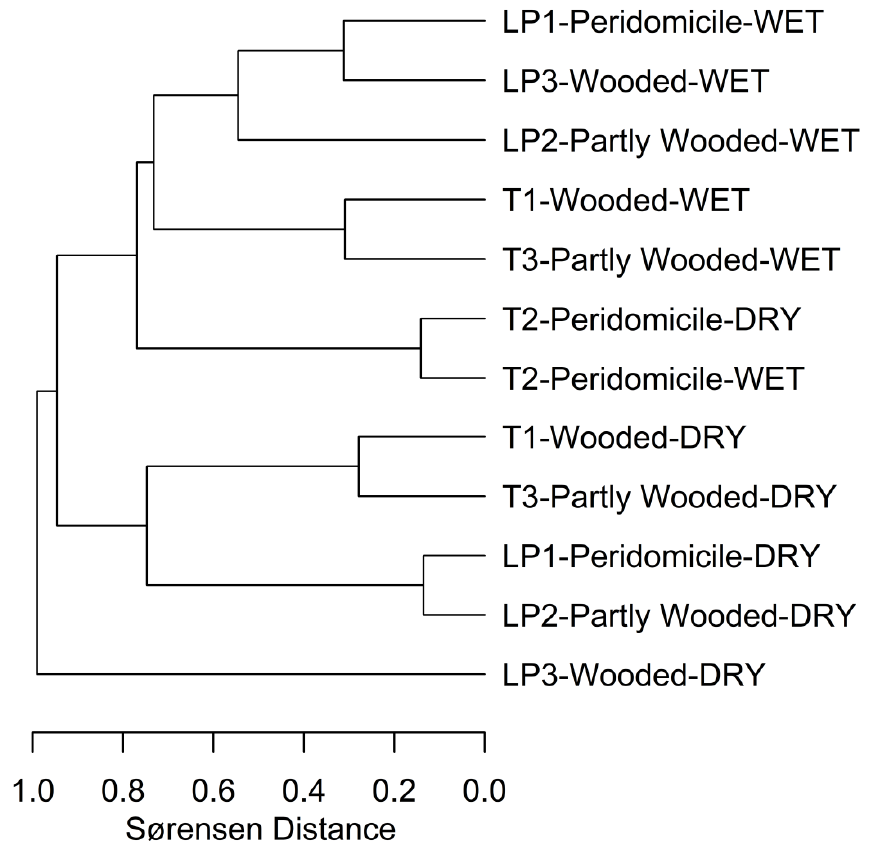
Figure 3. Cluster analysis of the Sørensen’s dissimilarity index for each plot and collection season. Labels stand for the following: Season collected: DRY (dry season); WET (wet season); Wooded; Partly Wooded, and Peridomicile plots are indicated in the labels, where LP (Las Pavas) and T (Trinidad de las Minas) codes correspond to the locations of Figure 1.